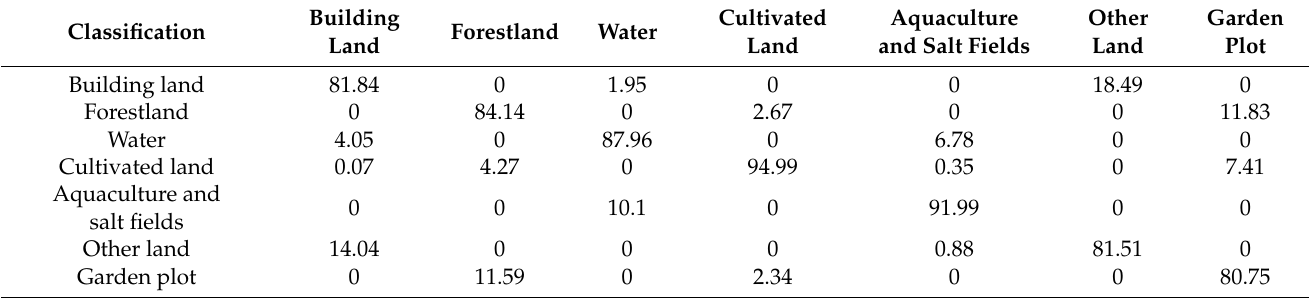
Table 2. Parameters of precision in the Yantai coastal zone in 2020